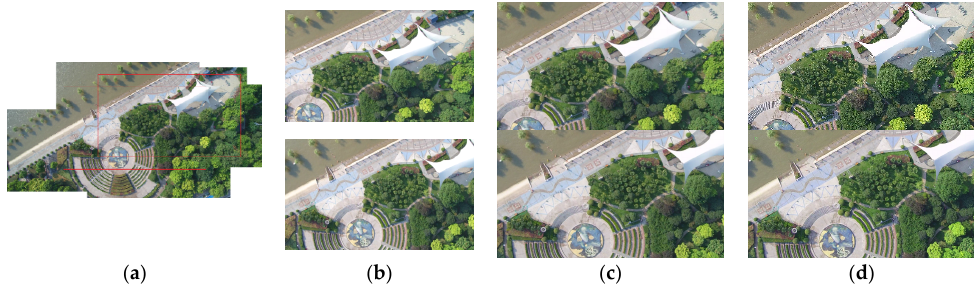
Figure 6. LBRL and reference images generation for UAV video clips. ( a ) The LBRL developed for the UAV video clip test; ( b ) cropped area from the LBRL (red rectangle in ( a )) according to the to-be- encoded video clip; ( c ) geometrical transformed reference image; ( d ) to-be-encoded video clip. First row—UAV video clip a; second row—UAV video clip d . Table 2. The overall BD-PSNR (dB) and BD-Rate (%) of LBRL-HEVC vs. HEVC with UAV data.